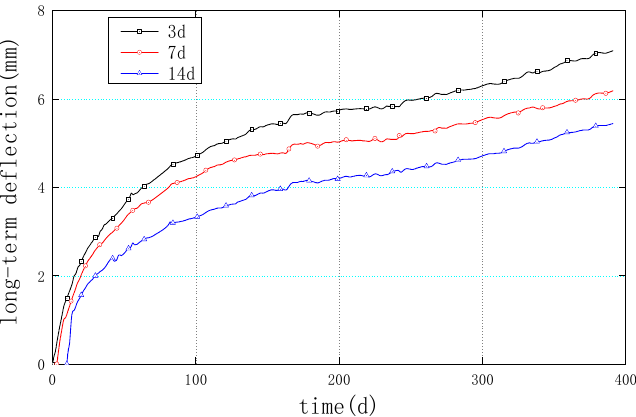
Figure 13. Evolution of the long ‐ term deflection of concrete T ‐ beam specimens at various loading ages (40% loading level).